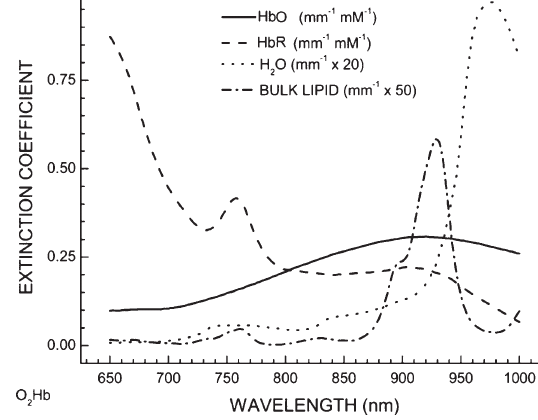
Fig. 1. Absorption spectrum of main chromophores in tissue in the NIR window (after [7]). differences and produce spatially resolved images